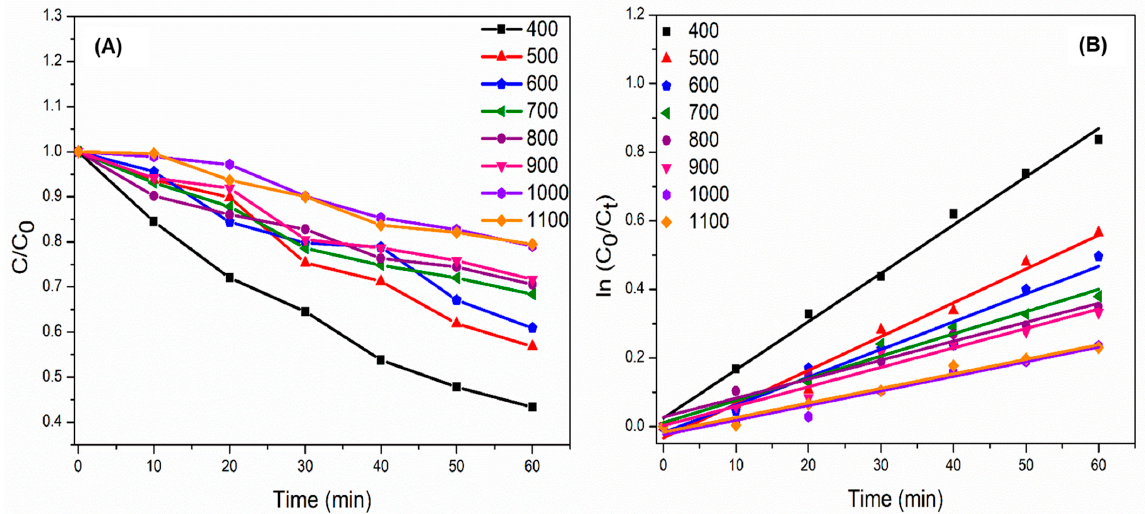
Figure 10. The photocatalytic degradation of green malachite under visible irradiation. ( A ) Photo- catalytic efficiency curve. ( B ) Graph of ln C 0 / C t versus irradiation time for the decomposition of the green malachite for CuFe 2 O 4 samples.